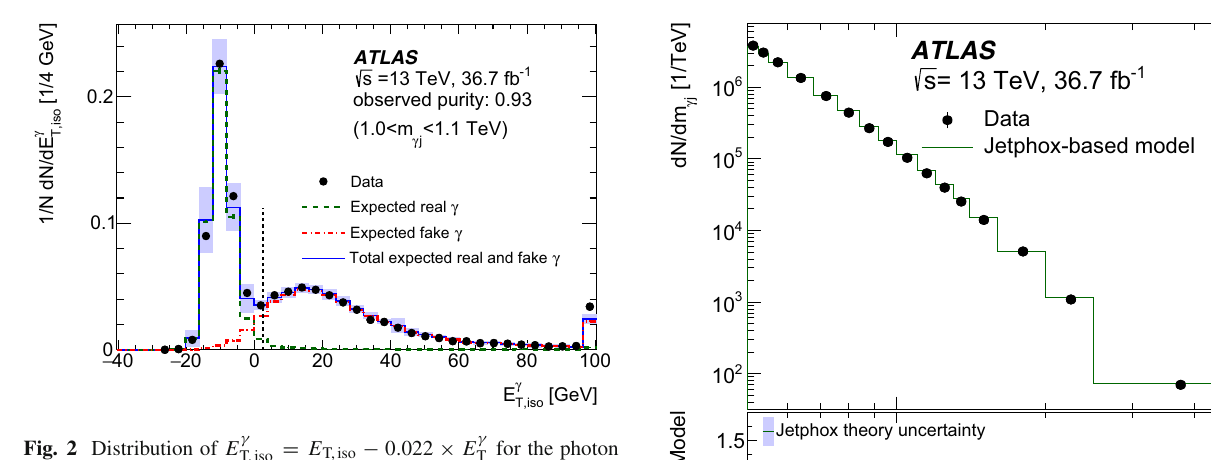
Stat. uncertainty (Data) ⊕ Syst.